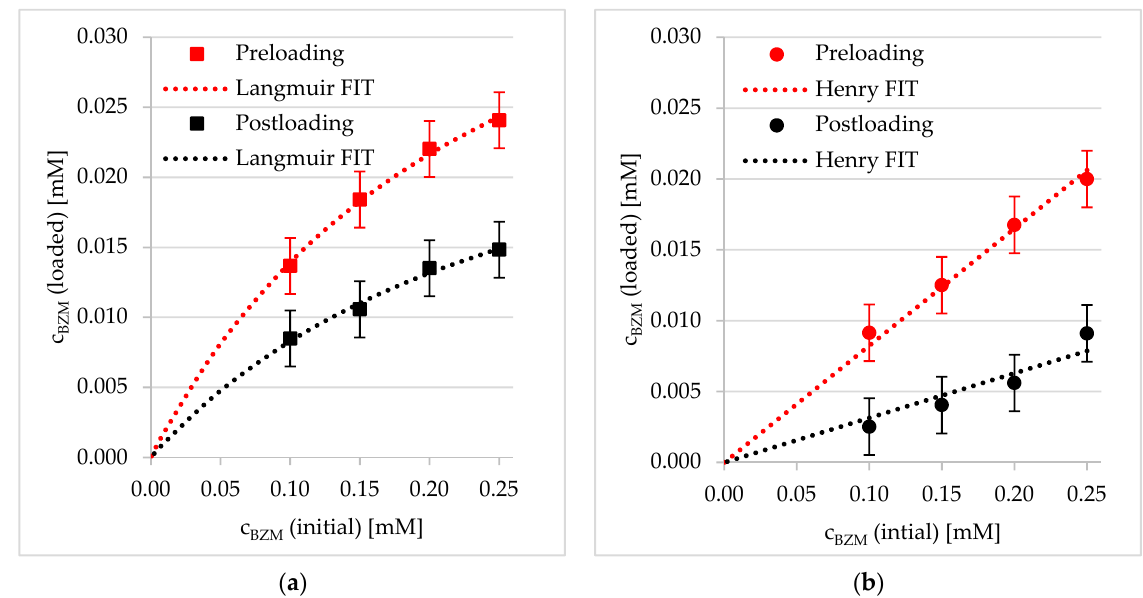
Figure 9. Comparison of adsorption isotherms of pre- and postloaded PEC NP for ( a ) PEC 0.7 with positive net charge and ( b ) PEC 1.4 with negative net charge.